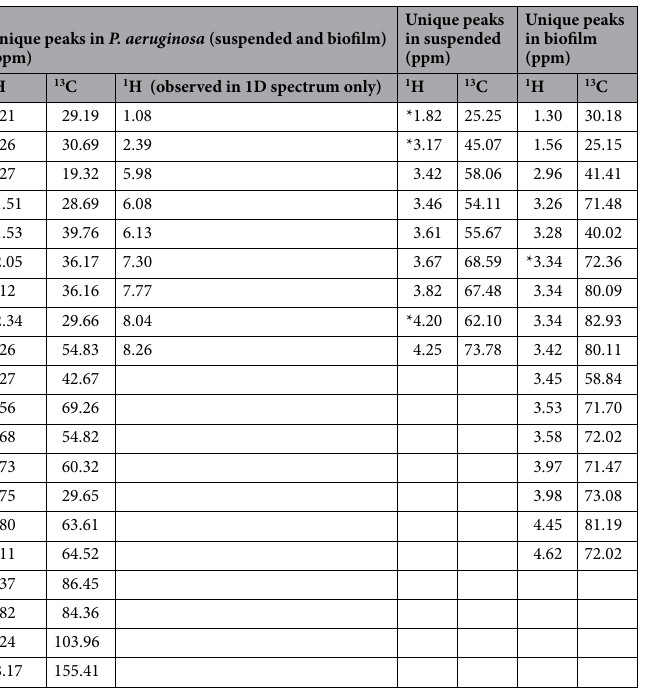
Table 1. Peaks uniquely detected in the 2D 13 C- 1 H HSQC and 1D 1 H NMR spectra in P. aeruginosa suspended and lawn biofilm cultures but absent in the uninoculated BSF control. The ‘*’ indicates peaks that are uniquely detected in both the 2D and 1D